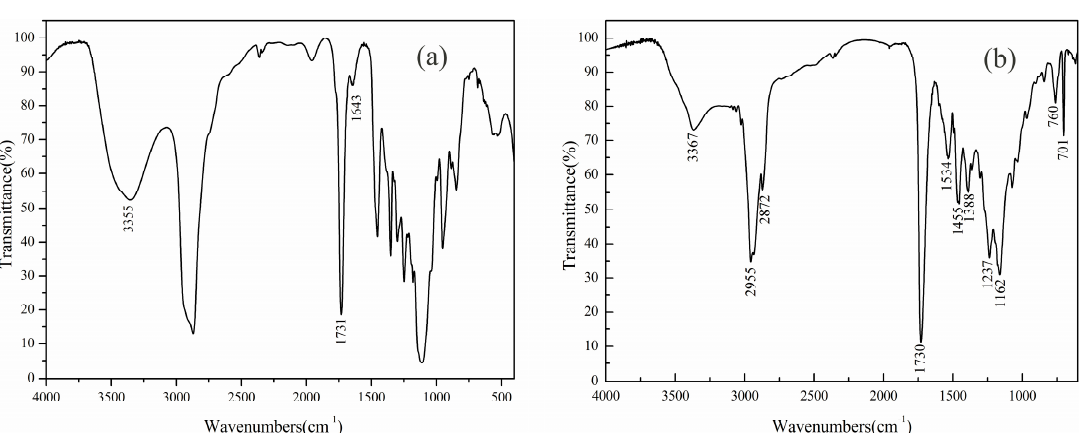
Table 3. Comparison of PAC and PET-AC on the properties of emulsion.